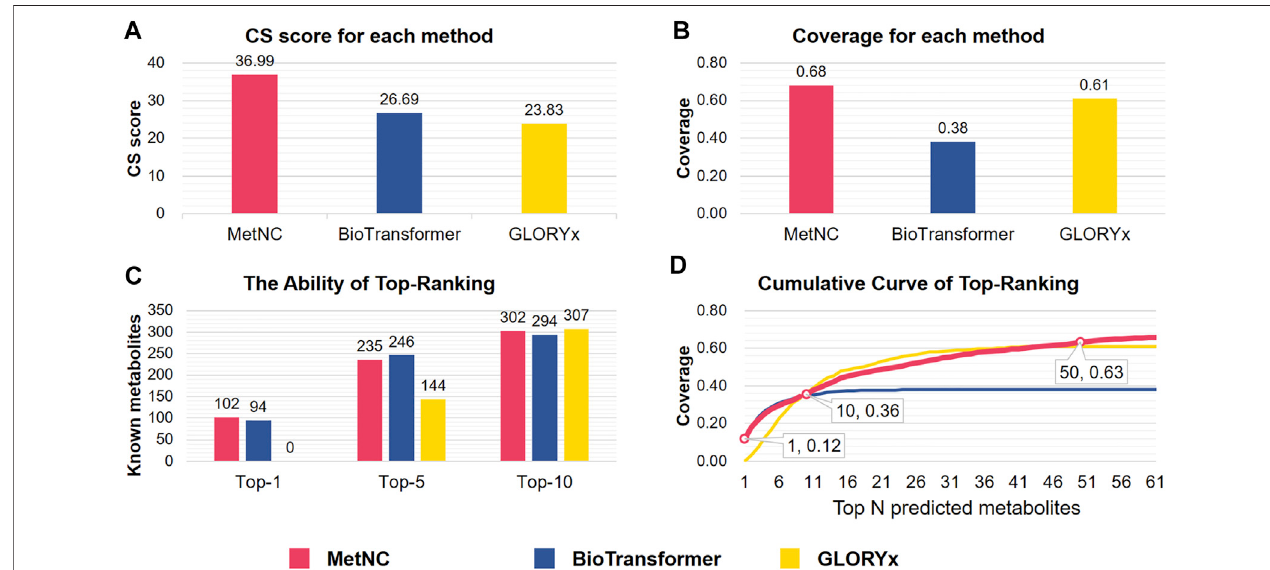
FIGURE2| Performancecomparison ofMetNC, BioTransformer,and GLORYxonthesourcingdataset( n =850). (A) CSofeachmethod. (B) Predictioncoverage of each method. (C,D) Ability of ranking known metabolites into the Top-N list. (D) Abscissa represents the accumulation from Top-1 to Top-N, while the ordinate indicates accumulative coverage.